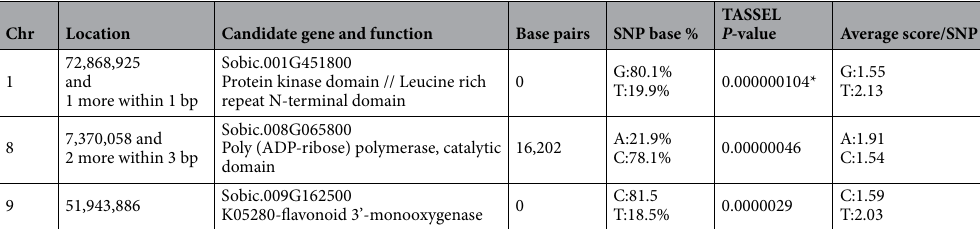
Table 2. Annotated genes nearest to the most significant SNPs associated with anthracnose to 1-leaf stage seedlings. The distance in base pairs to the nearest genes and P -value are listed. Two major alleles were calculated to verify significant differences for scores based on Student’s t-test, and SNPs failed to show differences were not considered as top candidates. * = passed Bonferroni correction (Bonferroni correction≈0.00000039).